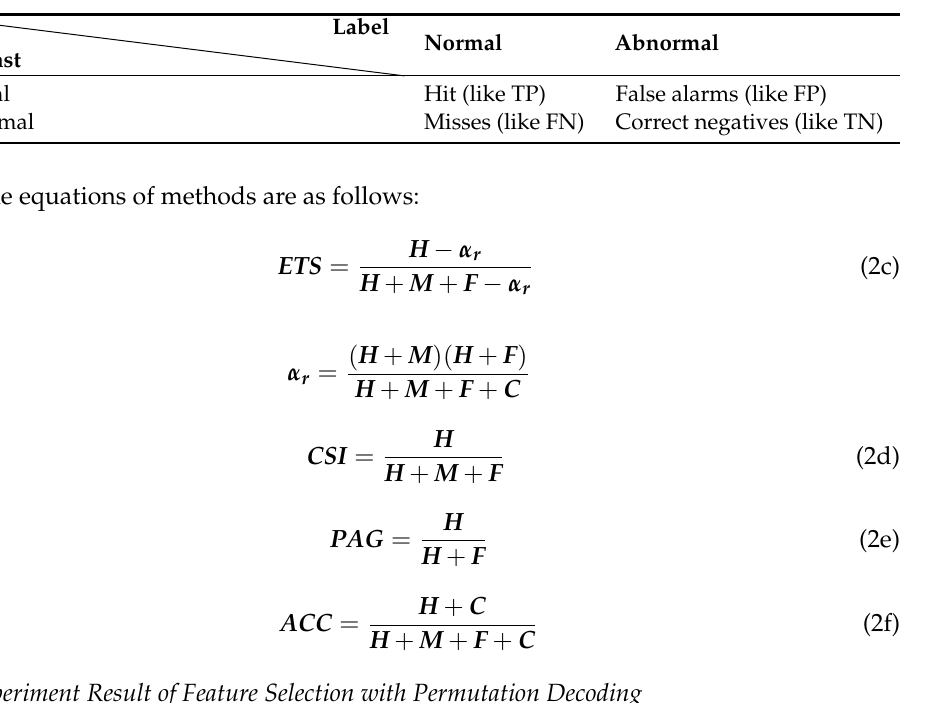
Table 2. Confusion matrix in forecast.